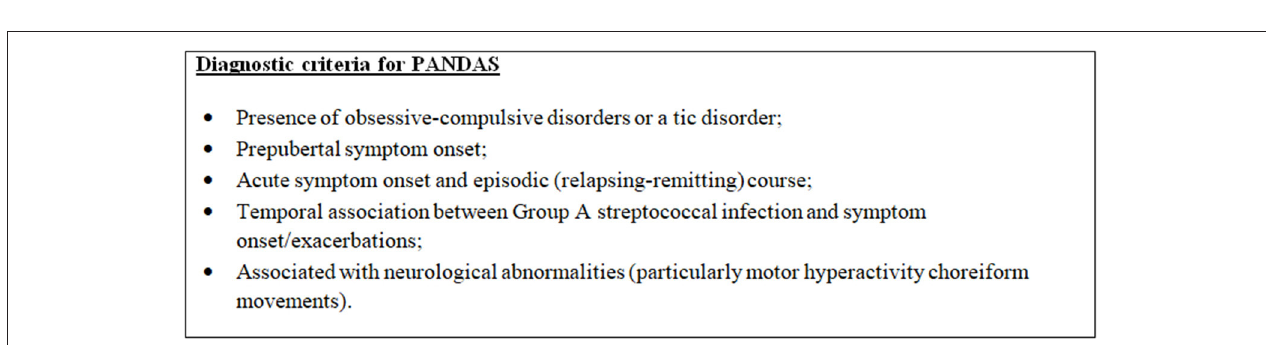
FIGURE 1 | Diagnostic criteria for pediatric acute-onset neuropsychiatric syndrome (PANS), modified from 2013 PANS Consensus Conference (2, 3).